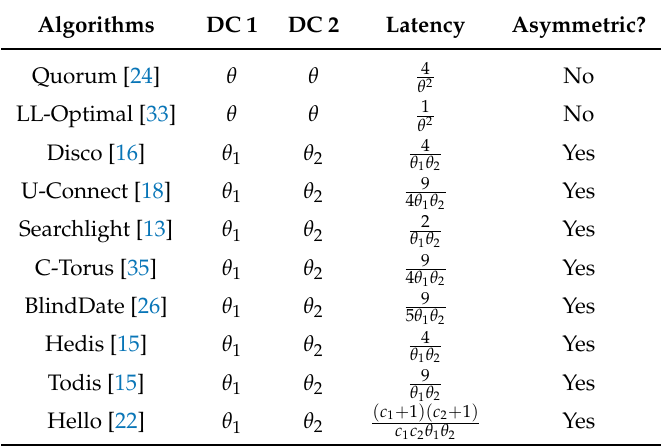
Table 2. Algorithms comparison for two